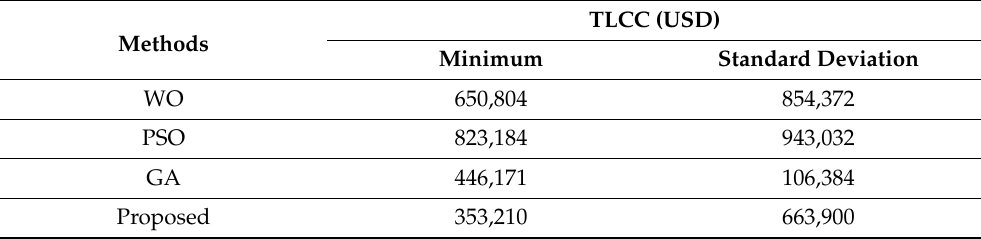
Table 3. Comparison of TLCC for solar/battery/ROD.